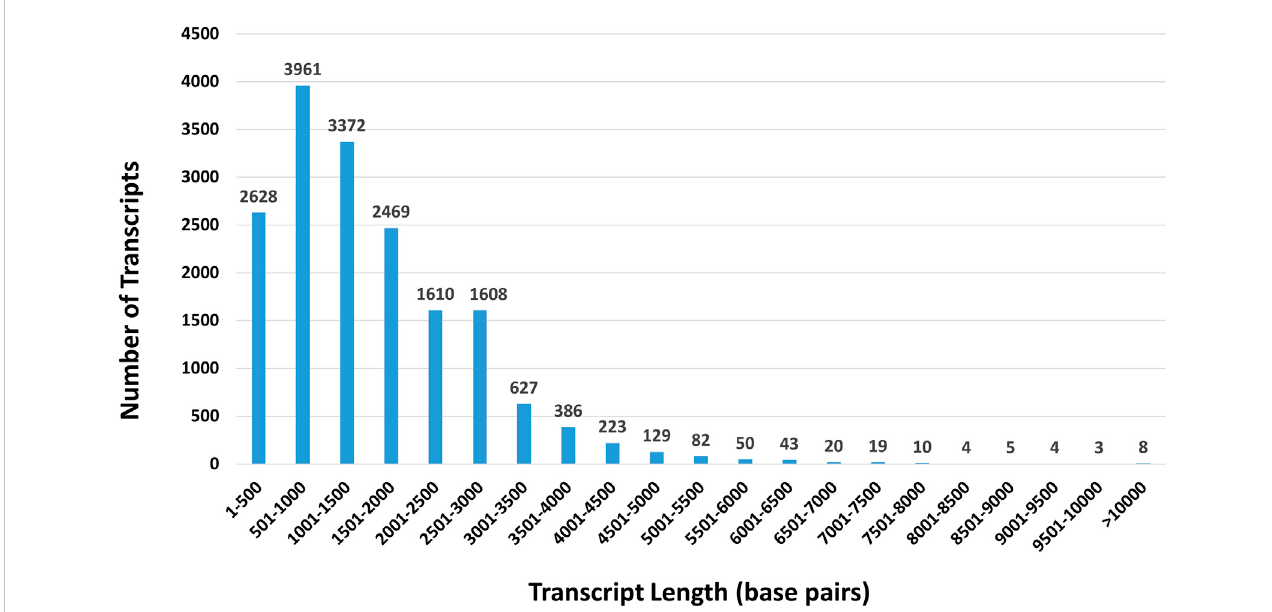
FIGURE 4 Distribution ofnucleotide lengths across 16,720 orthologous shrew transcript sequences.The distributionofsequence lengths among thecompleteset of 16,720 shrew transcripts were assessed. Sequences ranged from 201 bp to 15,430 bp. Most shrew transcripts were 4,000 bp or less in length. Fewer than 500 sequences were longer than 5,000 bp.